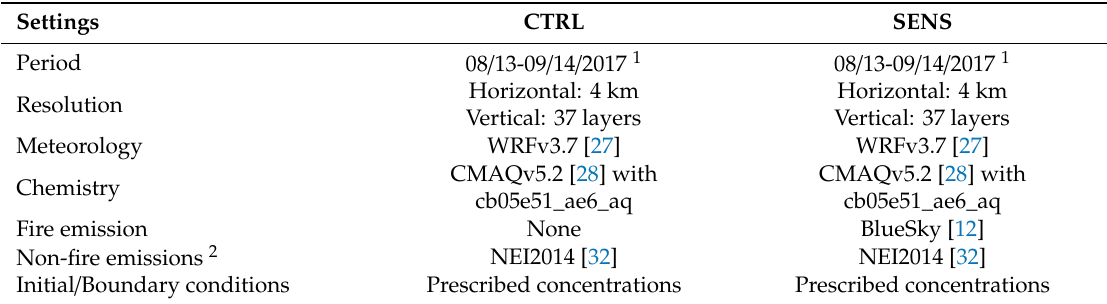
Table 1. The model simulation settings for the 2017 fire smoke case study over the PNW region. Settings CTRL SENS Period 08 / 13-09 / 14 / 2017 1 08 / 13-09 / 14 / 2017 1 Horizontal: 4 km Horizontal: 4 km Resolution Vertical: 37 layers Vertical: 37 layers Meteorology WRFv3.7 [27] WRFv3.7 [27] CMAQv5.2 [28] with CMAQv5.2 [28] with Chemistry cb05e51_ae6_aq Fire emission None BlueSky [12] Non-fire emissions 2 NEI2014 [32] NEI2014 [32] Initial / Boundary conditions Prescribed concentrations Prescribed